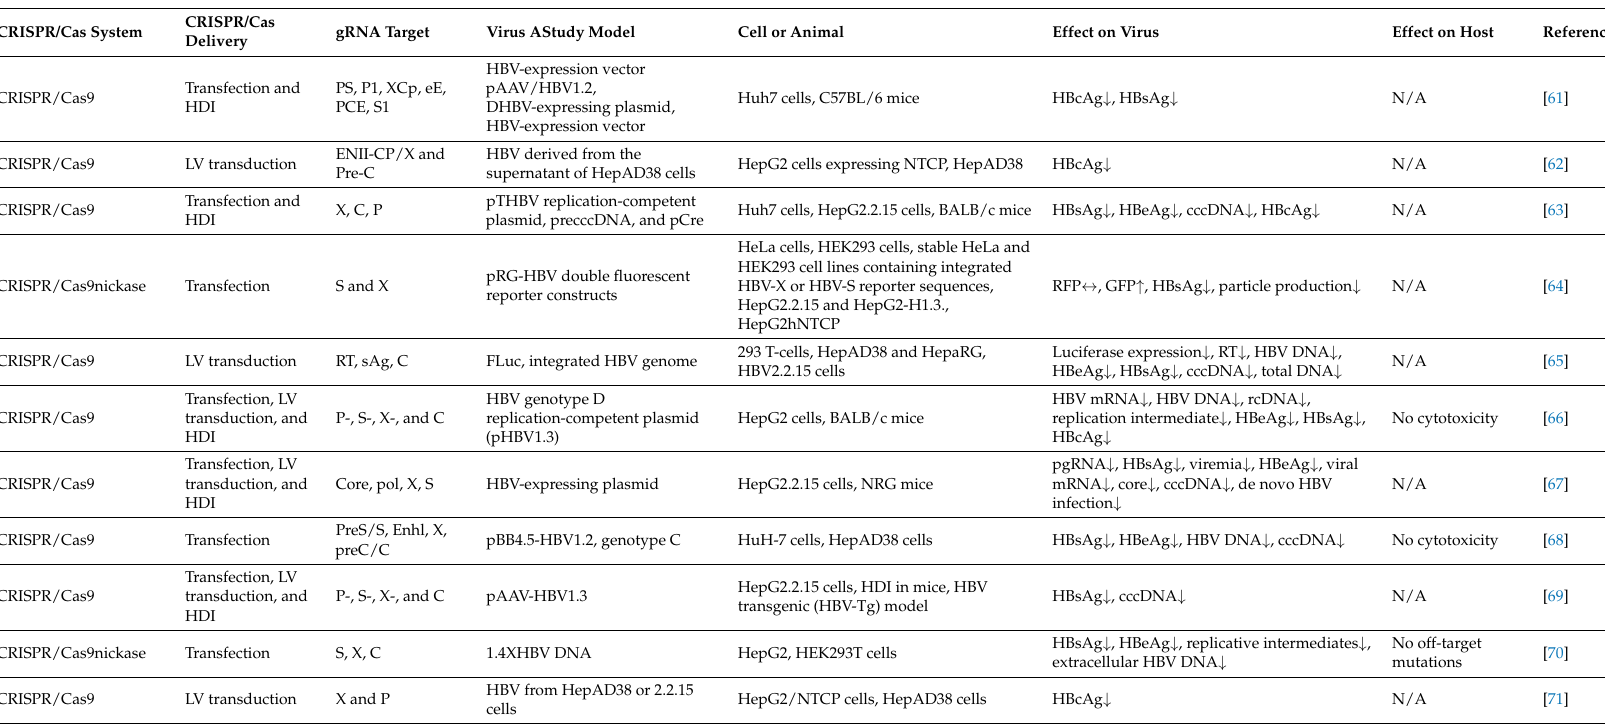
Table 2. Summary of CRISPR/Cas9-based antiviral studies targeting HBV. Abbreviations used within the table are as follows. HBV; hepatitis B virus, DHBV; duck hepatitis B virus, HBcAg; hepatitis B core antigen, HBsAg; hepatitis B surface antigen, NTCP; sodium-dependent uptake transporter, HBeAg; hepatitis B e antigen, cccDNA; covalently closed circular DNA, RFP; red fluorescence protein, rcDNA; relaxed circular DNA, NRG; non-obese diabetic-Rag(-)- γ chain(-),